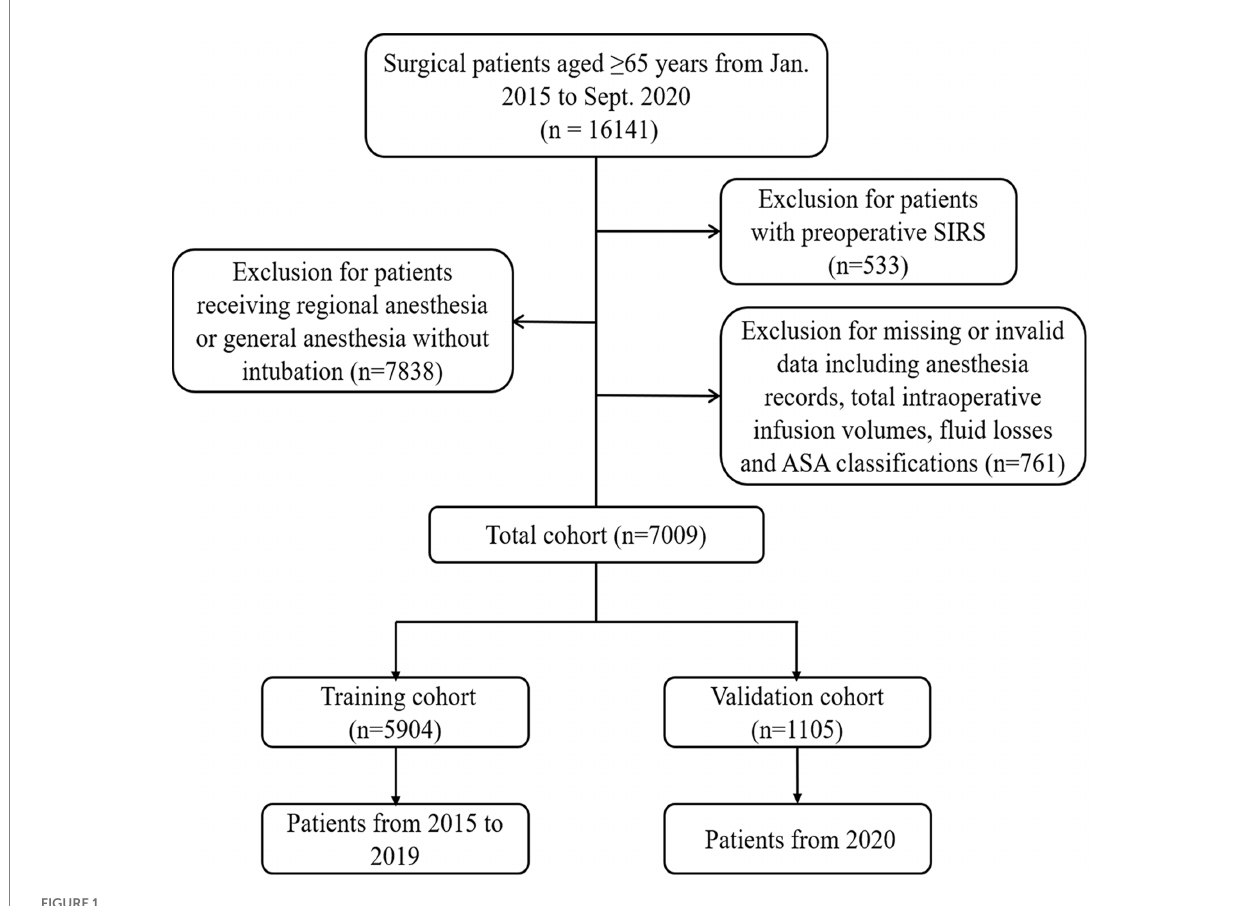
FIGURE 1 Flow chart demonstrating the patient selection